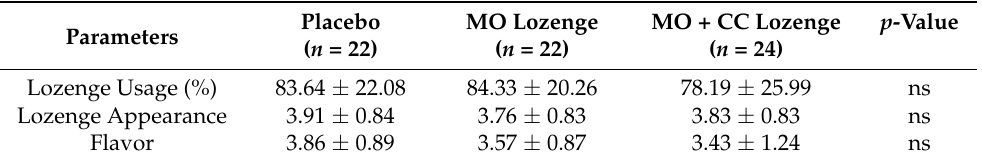
Table 6. The satisfaction and lozenge usage after 4 weeks. The different of lozenge usage and the satisfaction among three groups were analyzed using Kruskal–Wallis test at p < 0.05. The values were represented as mean ± SD, ns is not significant. MO: Moringa oleifera ; CC: Cyanthillium cinereum .